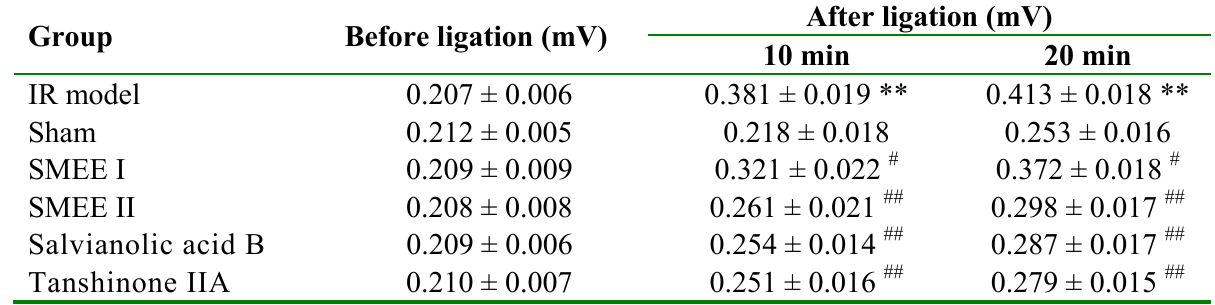
Table 1. Effect of S. miltiorrhiza ethanol extract on the ST segment in the rat electrocardiogram.